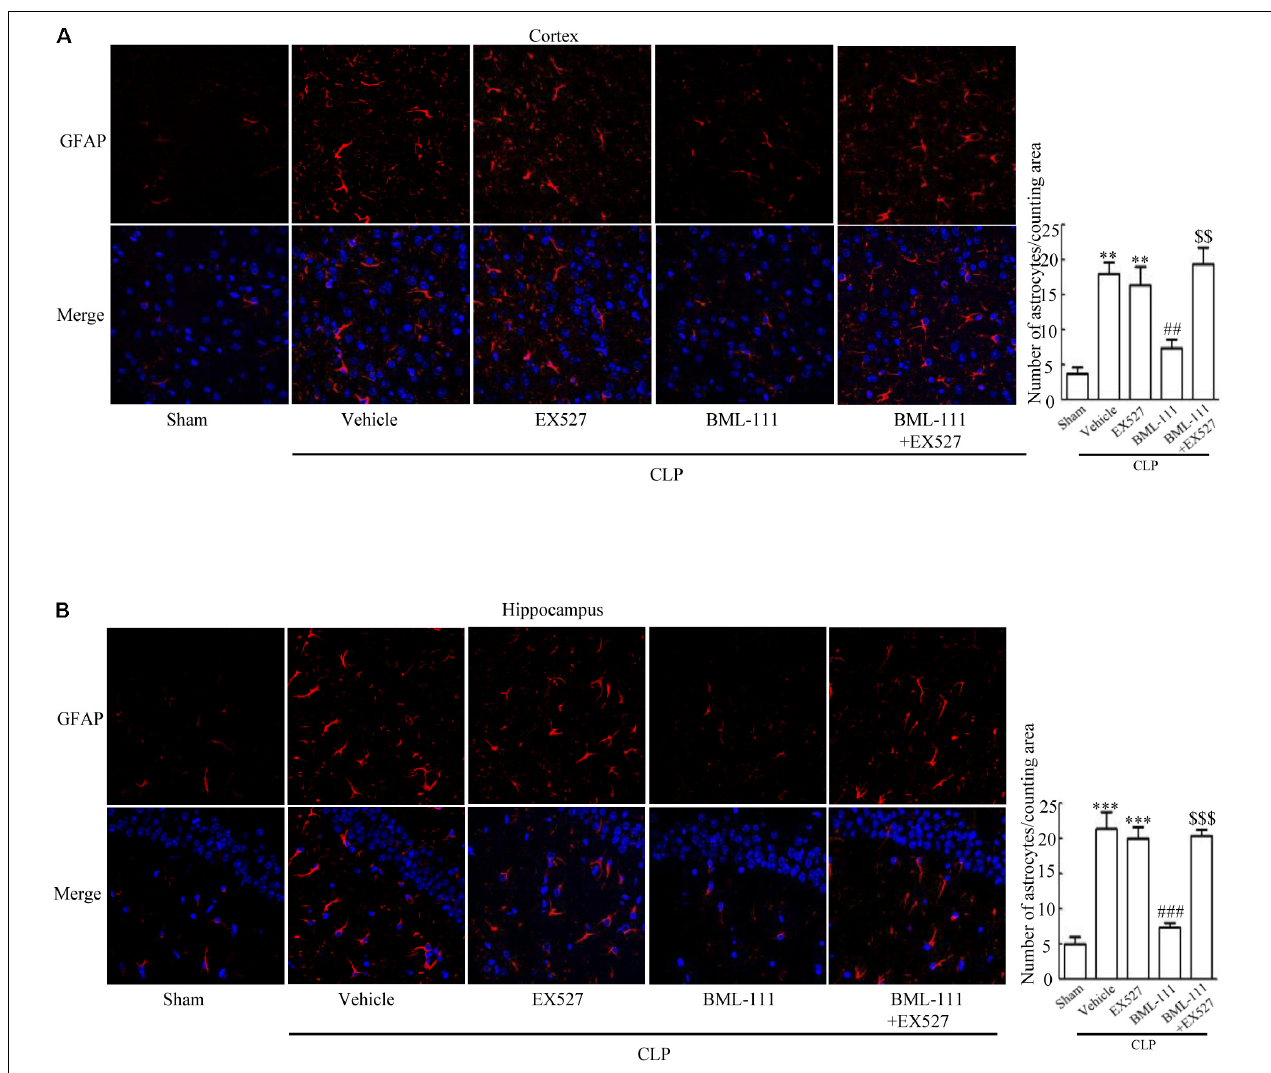
FIGURE 12 | BML-111 decreases the activation of astrocyte induced via SIRT1 in CLP. (A,B) CLP and EX527 increased the activated astrocyte when compared with sham group, and there did not differ between CLP + Vehicle group and CLP + EX527 group. BML-111 decreased the activated astrocyte related to CLP + Vehicle group. EX527 administration before CLP and BML-111 increased the activation of astrocyte compared with the CLP + BML-111 group. Scale bars indicate 50 µ m ( n = 3 surviving mice per group). ∗∗ P < 0.01, ∗∗∗ P < 0.001 represent CLP + Vehicle vs. Sham and CLP + EX527 vs. sham, ## P < 0.01, ### P < 0.001 represent CLP + BML-111 vs. CLP + Vehicle, $$ P < 0.01, $$$ P < 0.001 represent CLP + BML-111 + EX527 vs.